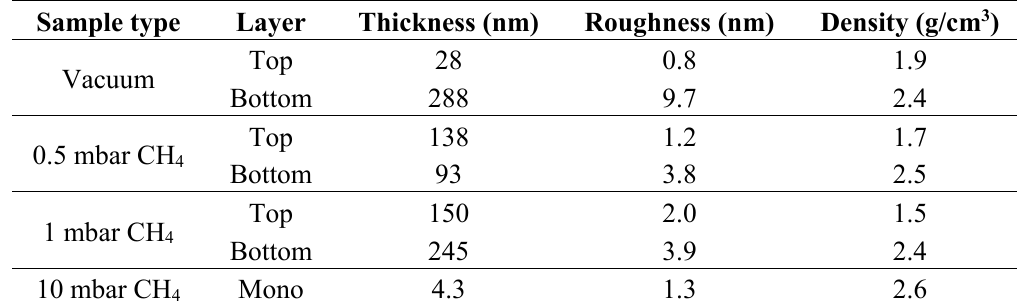
Table 2. Thickness, roughness and density values for the bi- and mono-carbon layers of each diamond-like carbon (DLC) sample, as obtained by XRR studies.